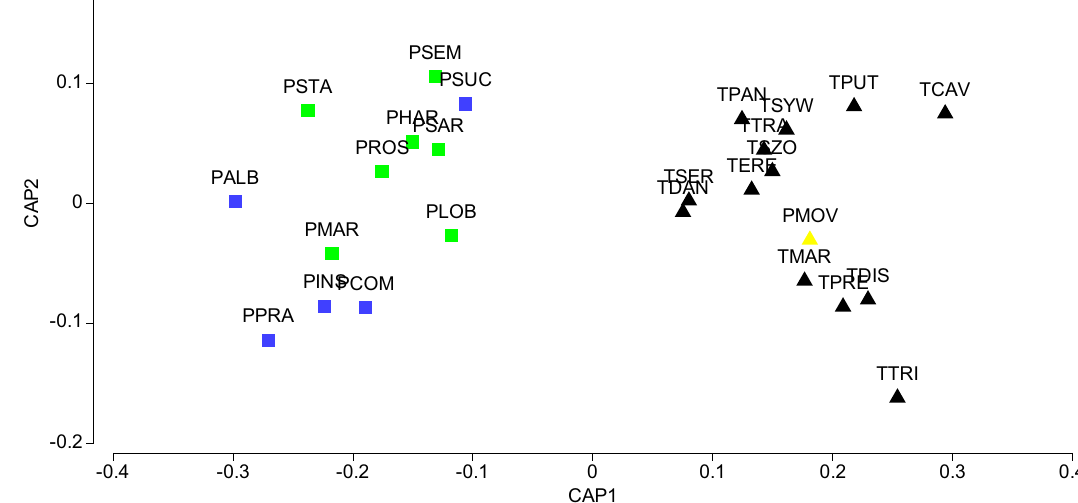
Figure 3. Canonical analysis of principal coordinates (CAP) plot of geometric morphometrics data of the valve shape, showing the position of Pseudocandona movilaensis sp. nov. (yellow triangle) based on its morphometric resemblances with the species of the genus Typhlocypris (black triangles) and those of the two species-groups of the genus Pseudocandona (green squares = compressa species-group, blue squares = rostrata species-group). For the species codes see Table